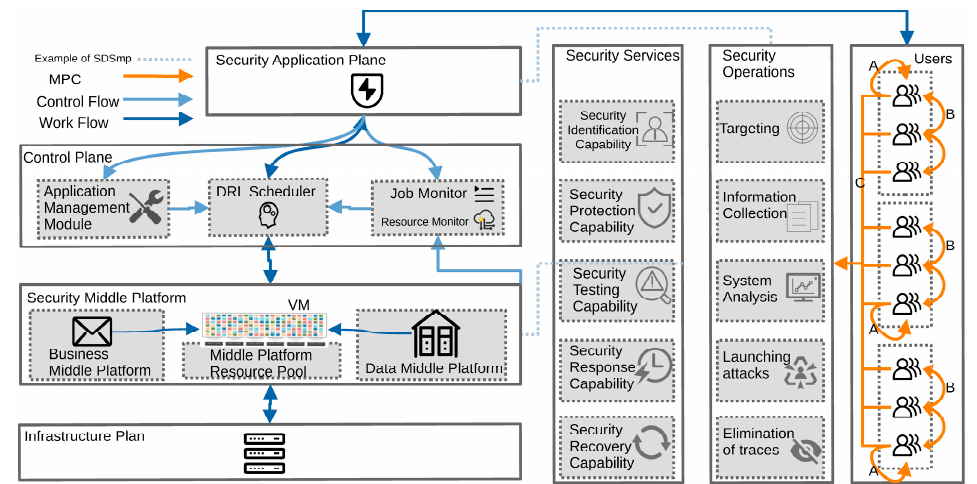
Figure 2. MPC-SDSmp cost optimization architecture based on DRL.